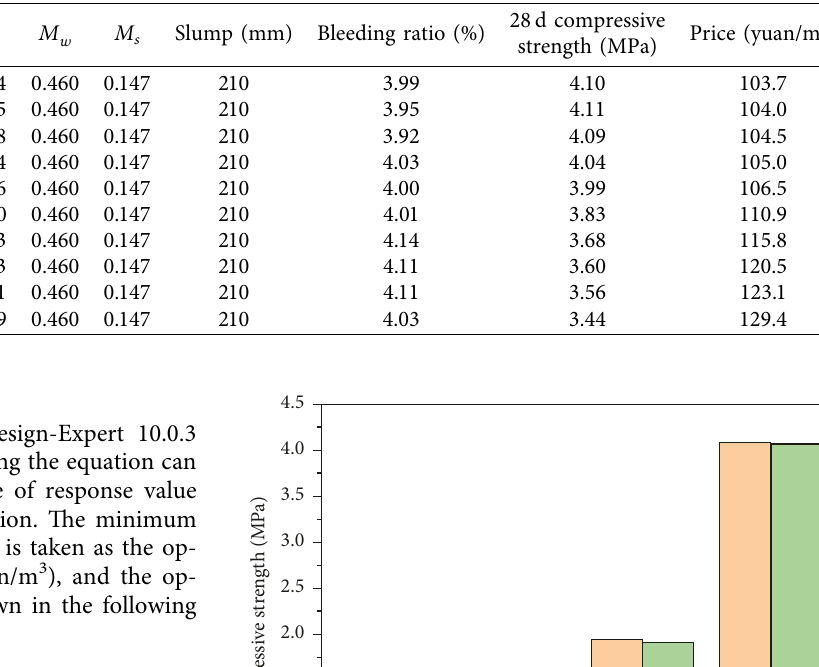
Table 8: Price of partial filling material mix ratio.